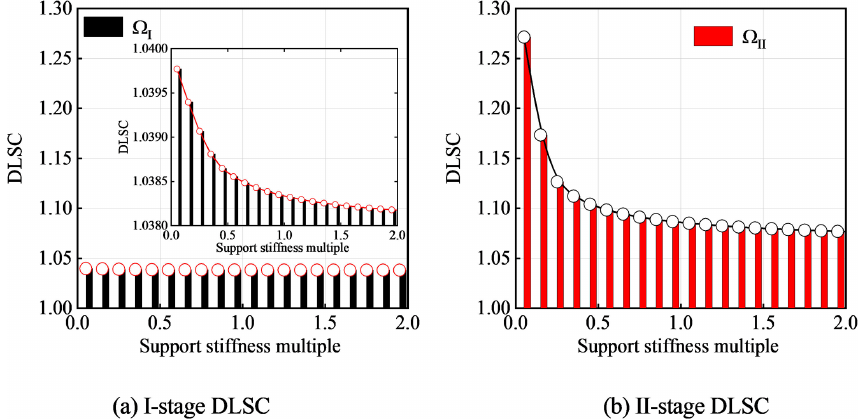
Figure 18. Influence of support stiffness on the dynamic load-sharing